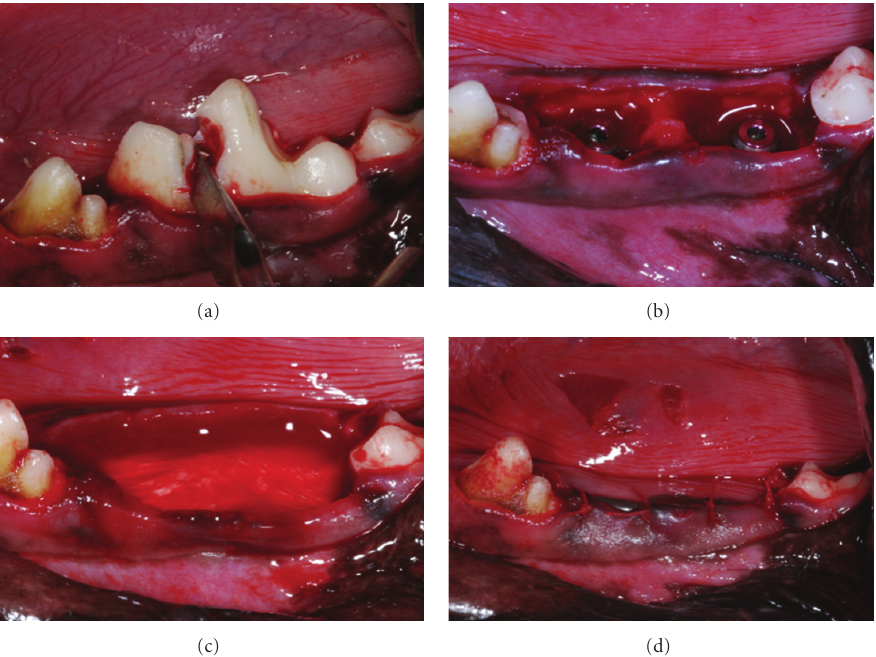
Figure 1: (a) Following sectioning, the teeth were extracted and (b) two 3.3 mm × 13 mm implants were placed in each of the sockets. (c) In one of the sides, a collagen-based membrane was placed and (d) extraction sockets with implants in place were closed with standard suture techniques.